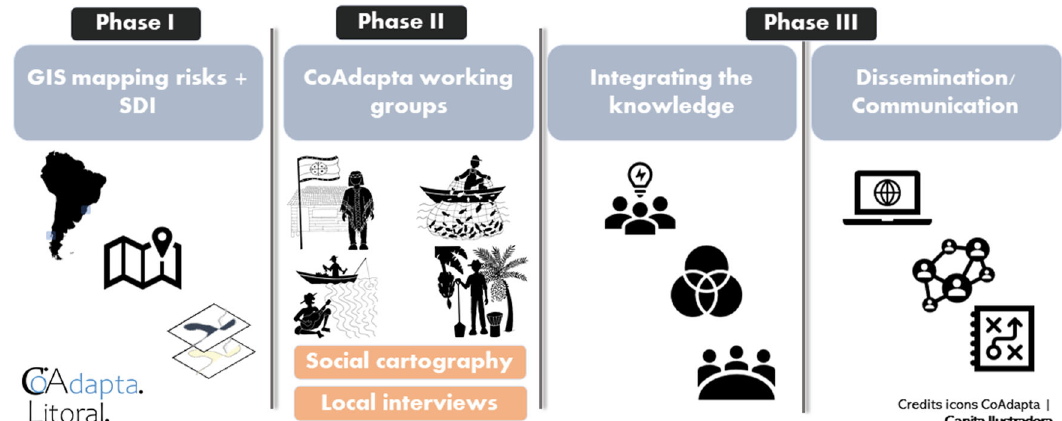
Fig. 2 Methodological approach. Phase I - GIS mapping and SDI, Phase II - CoAdapta working groups (WGs) and Phase III - integrating the knowledge and communication results.